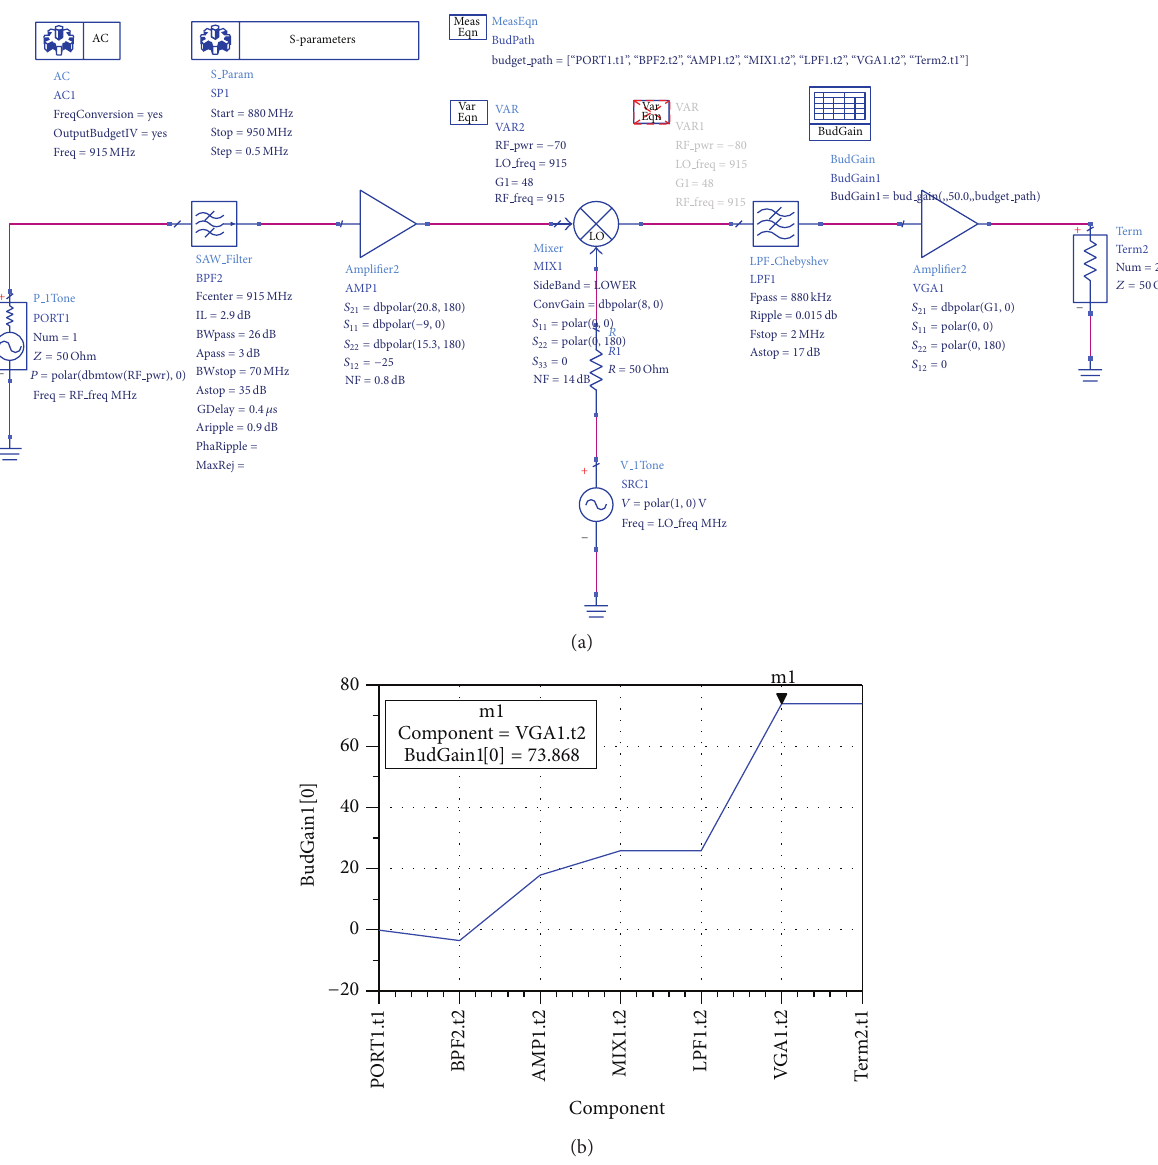
Figure 4: Link budget simulation of the proposed Rx circuit: (a) behavior model of the Rx circuit; (b) simulation result when the input power of the receiver is − 70dBm, and the voltage gain of the Rx PGA of the ADF9010 is 24 dB.